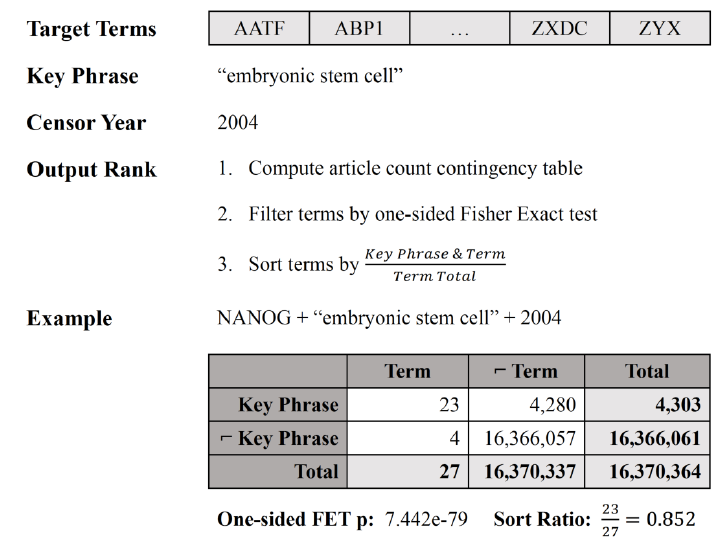
Figure 1. A diagrammatic example of KinderMiner for the key phrase “embryonic stem cell” and target term